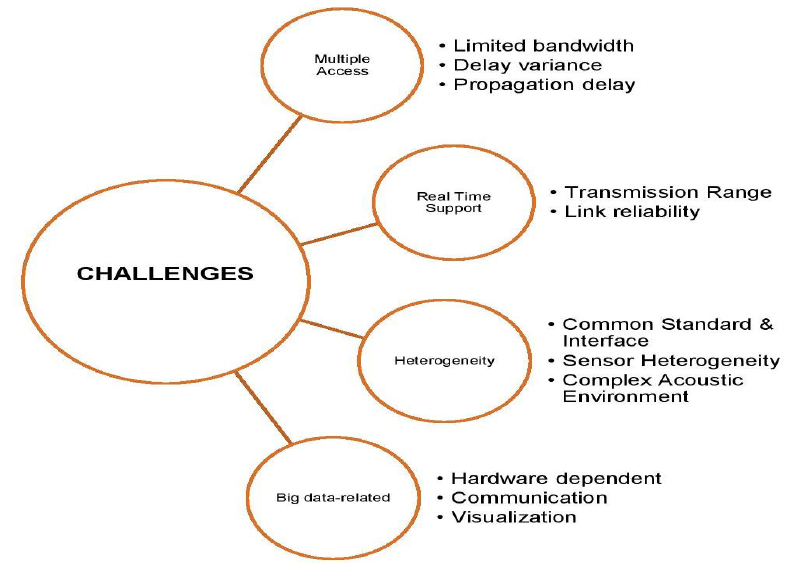
Figure 9. Open Research Challenges in